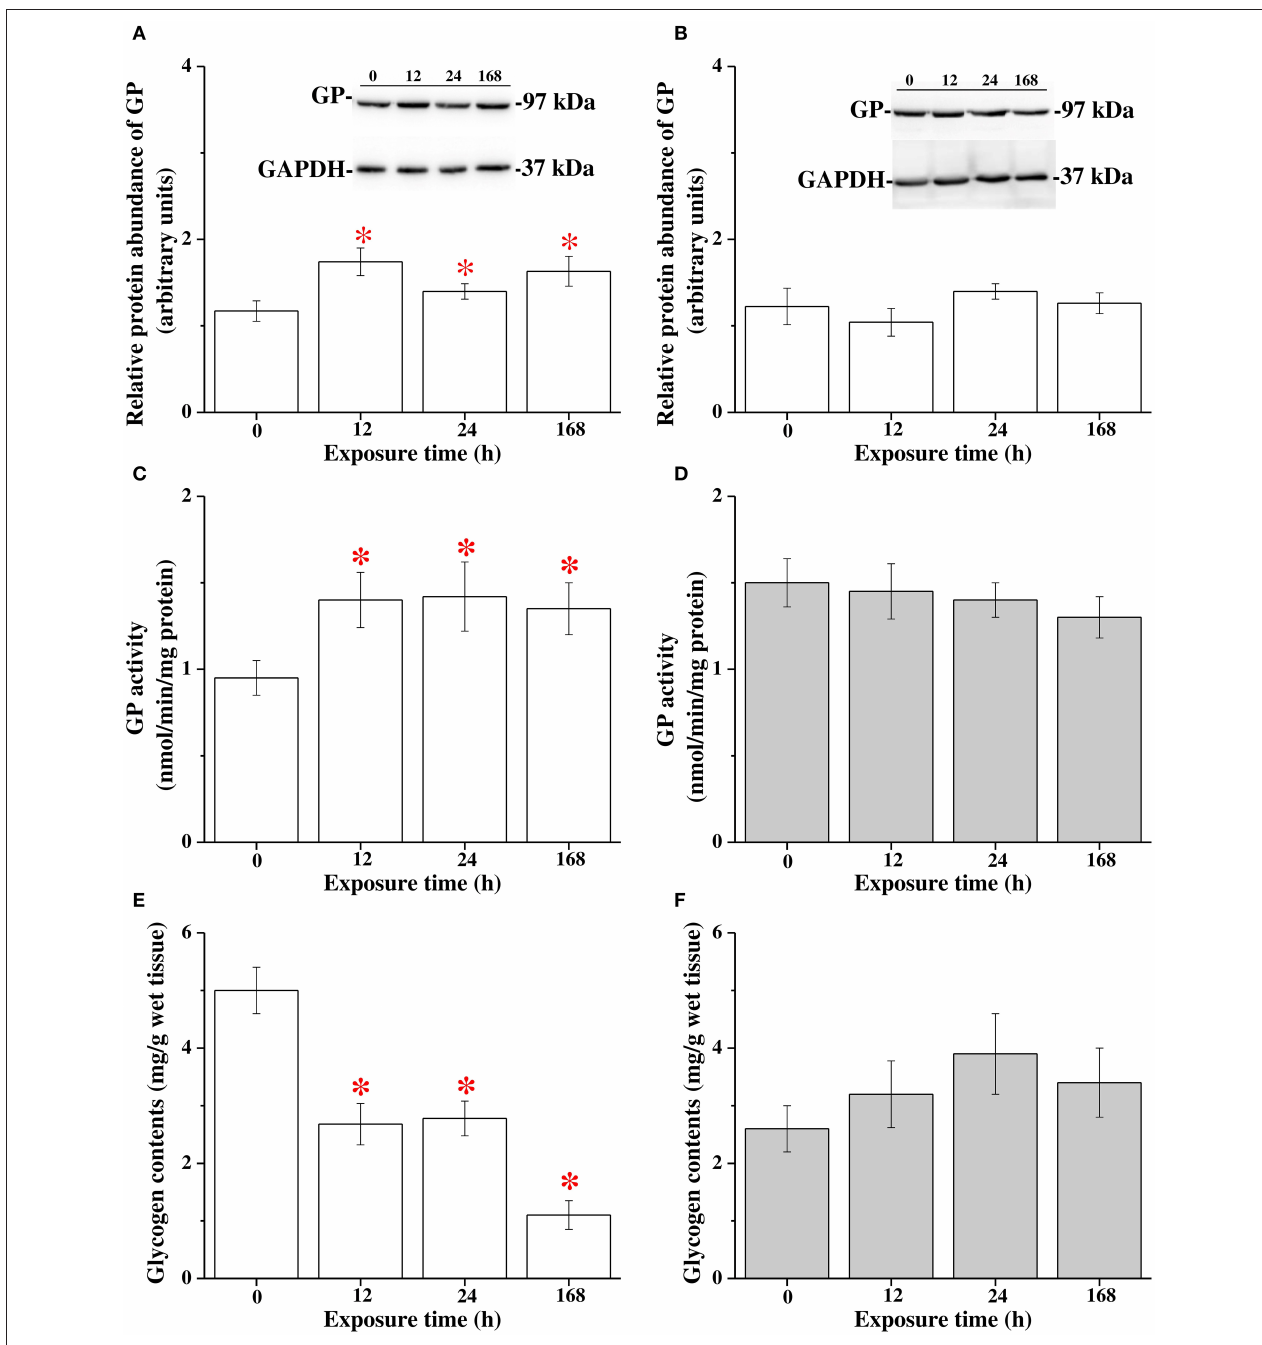
FIGURE 6 | The hypothermal stress experiments revealed glycogen catabolism in livers of freshwater (FW) and seawater (SW) milkfish after 18 ◦ C-exposure. The protein abundance of GP in FW (A) and SW (B) groups, GP activity in FW (C) and SW (D) groups, glycogen contents in FW (E) and SW (F) groups, respectively. Values are means ± SEM, n = 6. The asterisks indicate significant differences ( P < 0.05) compared to the 0h fish using one-way ANOVA with Dunnett’s